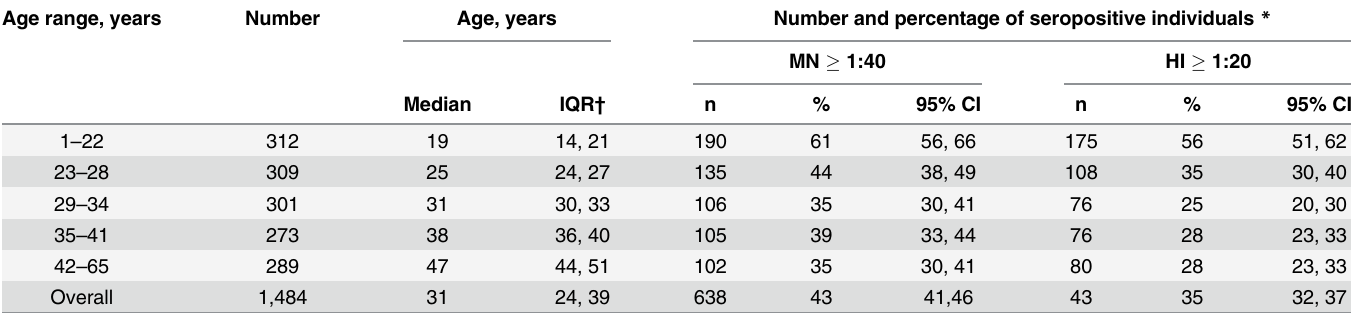
Table 2. Number and proportion of the 1,484 participants who tested positive to influenza A(H1N1)pdm09 at the MN (cid:3) 1:40 and HI (cid:3) 1:20 thresh- olds, by quintiles of age. Age range, years